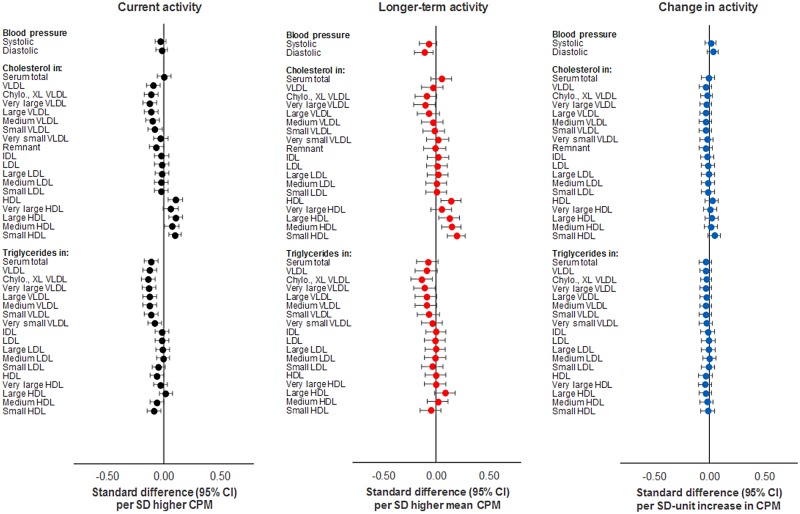
Associations of total activity (CPM) with blood pressure, cholesterol, and triglycerides at age 15y in ALSPAC.Metabolic traits are in standardised units. Current activity defined as measure at age 15y. Longer-term activity defined as mean of 3 measures (at age 12y, 14y, and 15y). Change in activity defined as difference between measures at age 12y and 15y. Models are adjusted for age, sex, ethnicity, maternal education, device wear time and wear month, smoking and alcohol (for current activity), and fat mass index (based on current, mean, or change values) across measures at age 12y, 14y, and 15y. ALSPAC, Avon Longitudinal Study of Parents and Children; CPM, counts per minute.